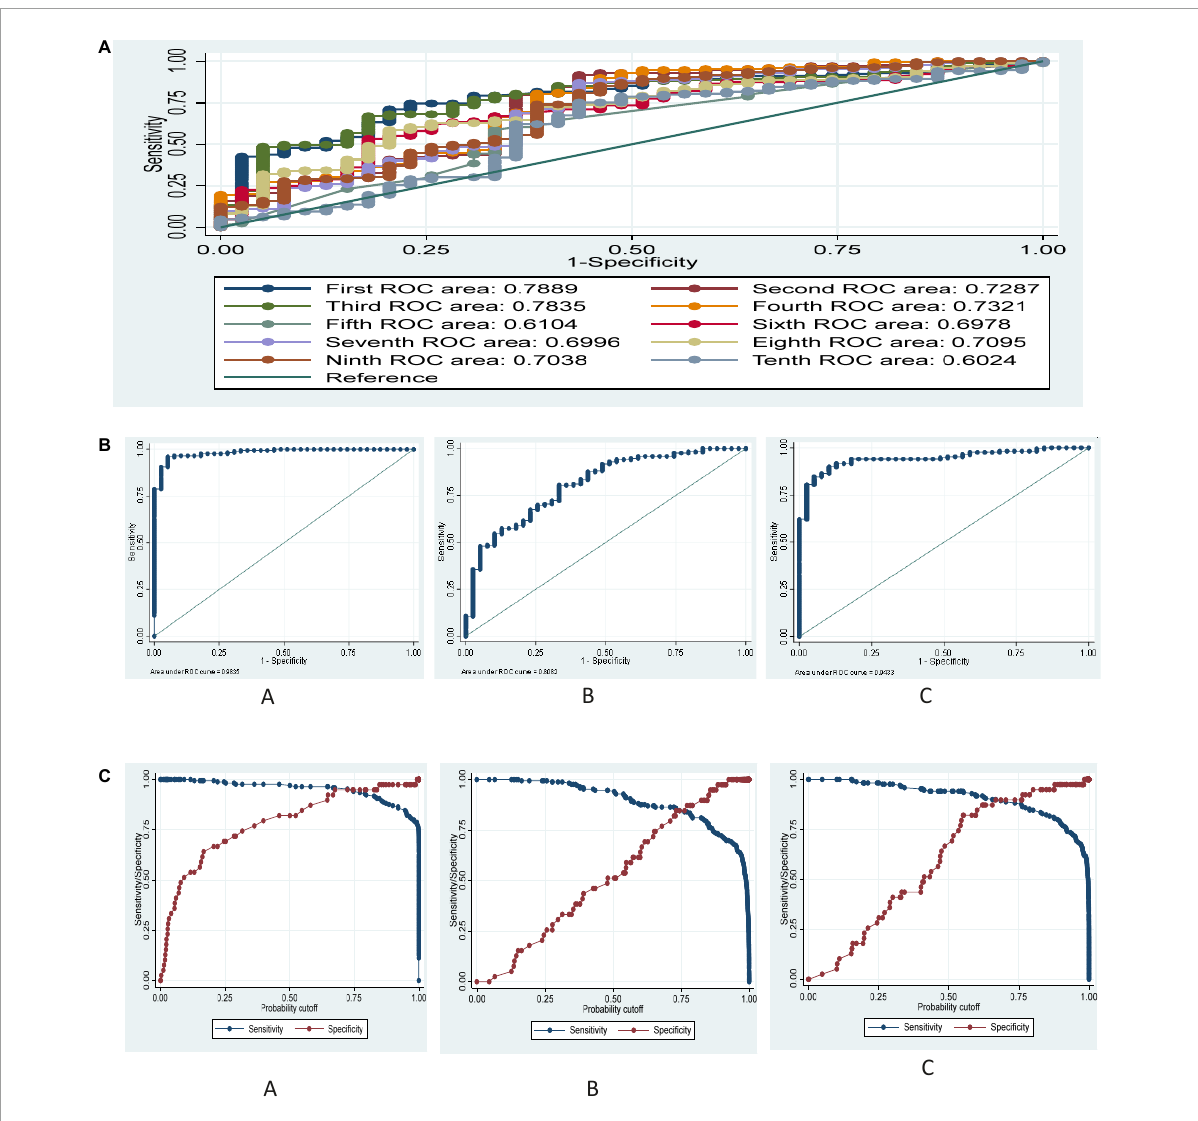
FIGURE2 (A) ROC curve for ten formulae based on derivation data set. Ho: area (First) = area (Second) = area (Third) = area (Fourth) = area (Fifth) = area (Sixth) = area (Seventh) = area (Eighth) = area (Ninth) = area (Tenth), chi 2 (9) = 205.6, P < 0.001, (B) ROC curve for ten (A) , first five (B) , and second five (C) new integrated weaning indices after multiple logistic regression based on the derivation data set. (C) ROC curve for sensitivity and specificity tradeoff for ten (A) , first five (B) , and 2nd five (C) new integrated weaning indices after multiple logistic regression based on derivation data